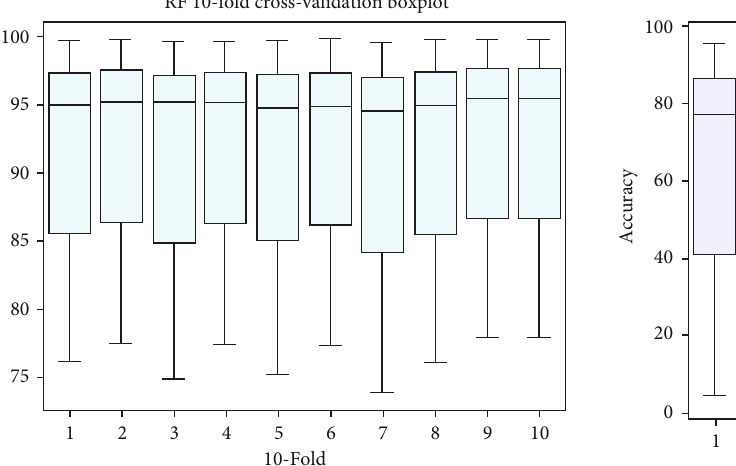
Figure 8: Box plot for Random Forest. Figure